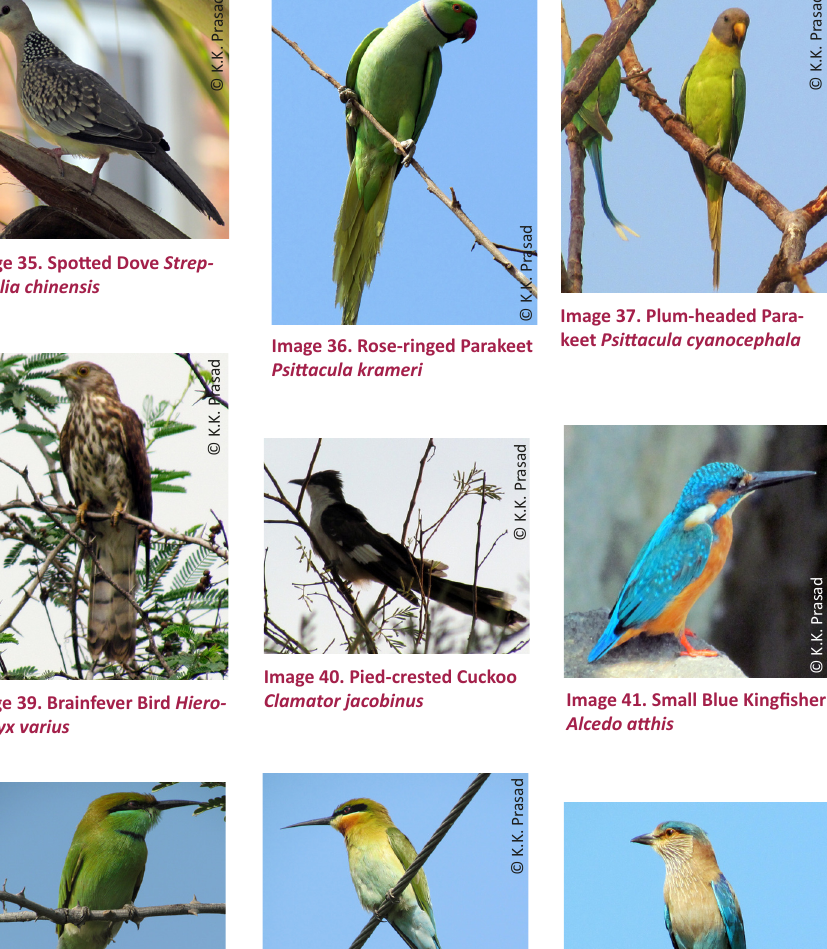
Image 42. White-breasted King- fisher Halcyon smyrnensis